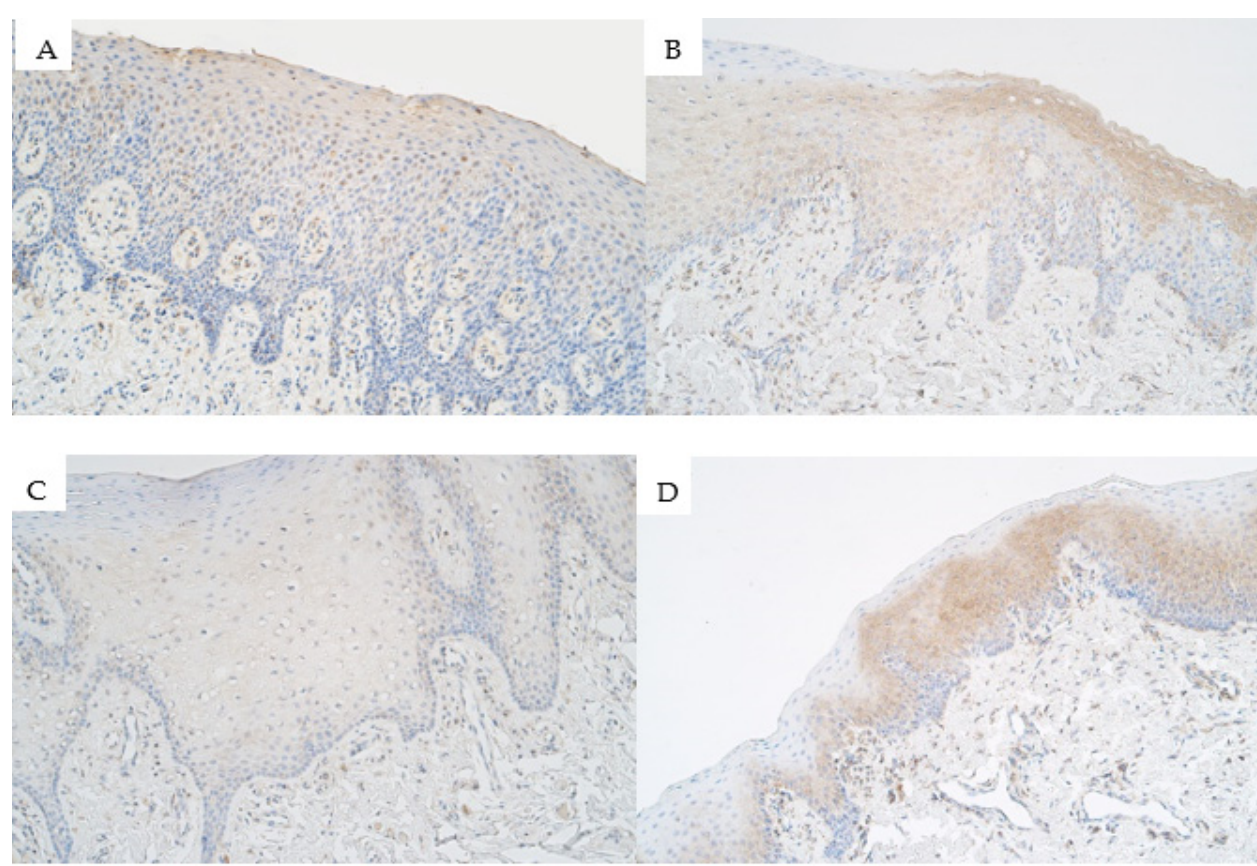
Figure 3. Immunoreactive structures for paired box 9 ( PAX9 ) in cleft affected tissue. ( A ) Control group tissue with a moderate number of PAX9 -containing epitheliocytes in the surface epithelium and barely detectable PAX9 -positive cells in the connective tissue, PAX9 IMH, 200 × . ( B ) Unilateral cleft lip affected tissue with moderate number of PAX9 epitheliocytes in the patient epithelium and a few PAX9 -containing structures in the connective tissue, PAX9 IMH, 200×. ( C ) Bilateral cleft lip affected tissue with a few PAX9 -positive structures in the surface epithelium and a few PAX9 -containing cells in the connective tissue, PAX9 IMH, 200×. ( D ) Isolated cleft palate affected tissue with a moderate number of PAX9 -positive epitheliocytes in the surface epithelium and a few PAX9 -positive structures in the connective tissue, PAX9 IMH, 200×.